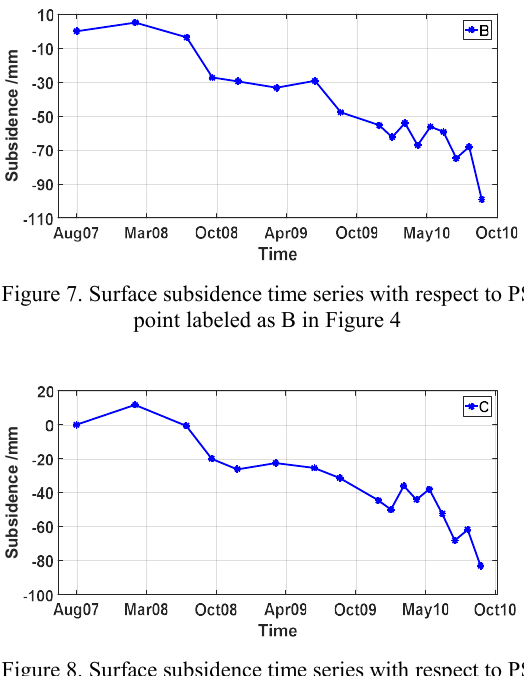
Figure 8. Surface subsidence time series with respect to PS point labeled as C in Figure 4